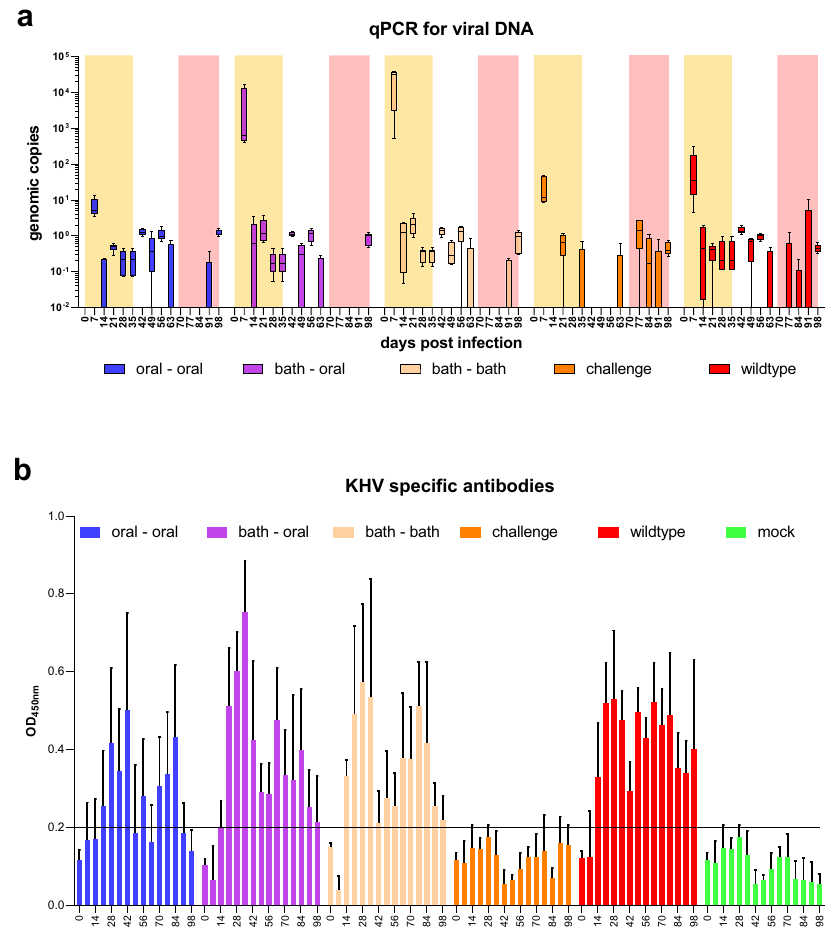
Fig. 4 Genetic and serological data of different vaccine applications. Viral load in gill swabs was recorded over the whole time of the trial by qPCR detection of viral DNA a . The fi rst fi ve weeks (prime) are marked by a yellow background, while a white background is used for the next fi ve weeks (boost), and the red background for the last fi ve weeks after challenge. Boxplot: center line — median, limits — 25th and 75th percentiles, whiskers — minimum and maximum. Humoral immune response was determined by ELISA b . The assay on plates coated with virus particles detects KHV-speci fi c antibodies, which are present after vaccination/infection. Error bars represent standard